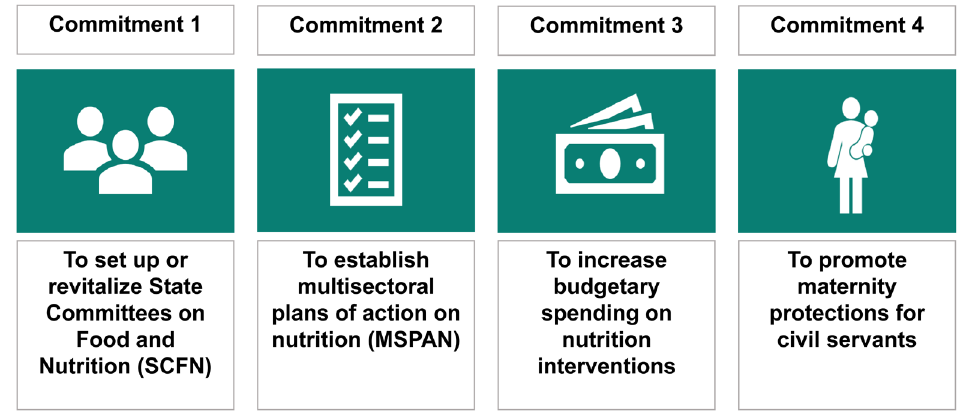
Figure 3. Nigeria Governors’ Forum commitments in